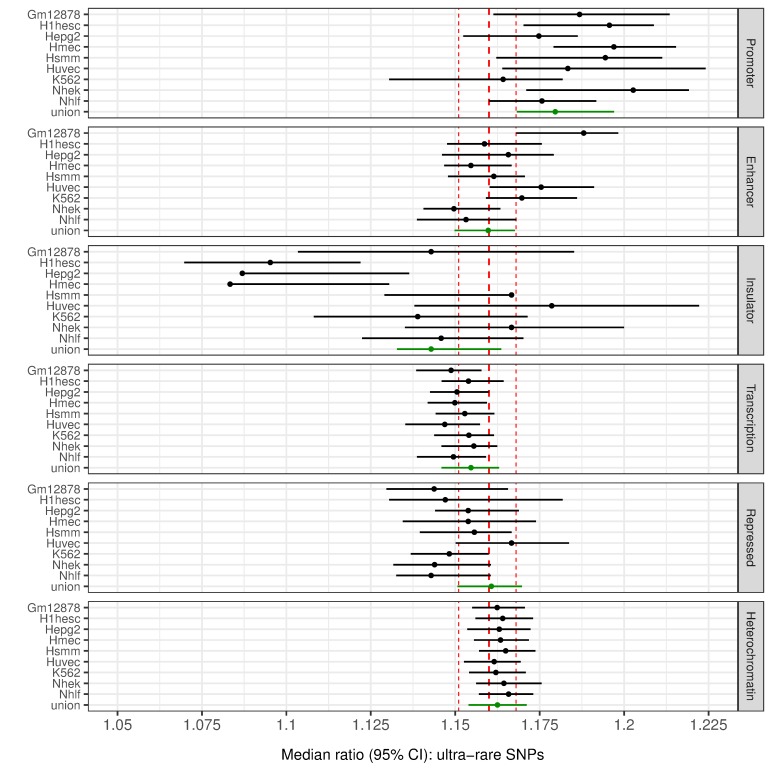
Ultra-rare SNP variant loads in functionally annotated non-coding regions.Circle dots represent the ratio of the median number of variants in a VIKING individual to the median number of variants in an LBC individual; whiskers are 95% CI based in 10,000 randomly selected LBC subsets (n = 269, with replacement). Significance: at least 95% of the 10,000 subsets have p ≤ 2x10-4 (Bonferroni corrected) and no overlap between the 95% CI for the LBC and the VIKING median values. The red vertical lines represent the median genome-wide load for ultra-rare SNPs and its 95% CI. The higher variance in the Insulator regions estimates could be explained by their relatively small size (17.4Mb). Gm12878: B-lymphoblastoid cells, H1hesc: embryonic stem cells, Hepg2: hepatocellular carcinoma cells, Hmec: mammary epithelial cells, Hsmm: skeletal muscle myoblasts, Huvec: umbilical vein endothelial cells, K562: erythrocytic leukemia cells, Nhek: normal epidermal keratinocytes, Nhlf: normal lung fibroblasts, union: an aggregated comparison between the two cohorts for this chromatin state by considering the union of state’s regions annotated in any of the 9 cell types.